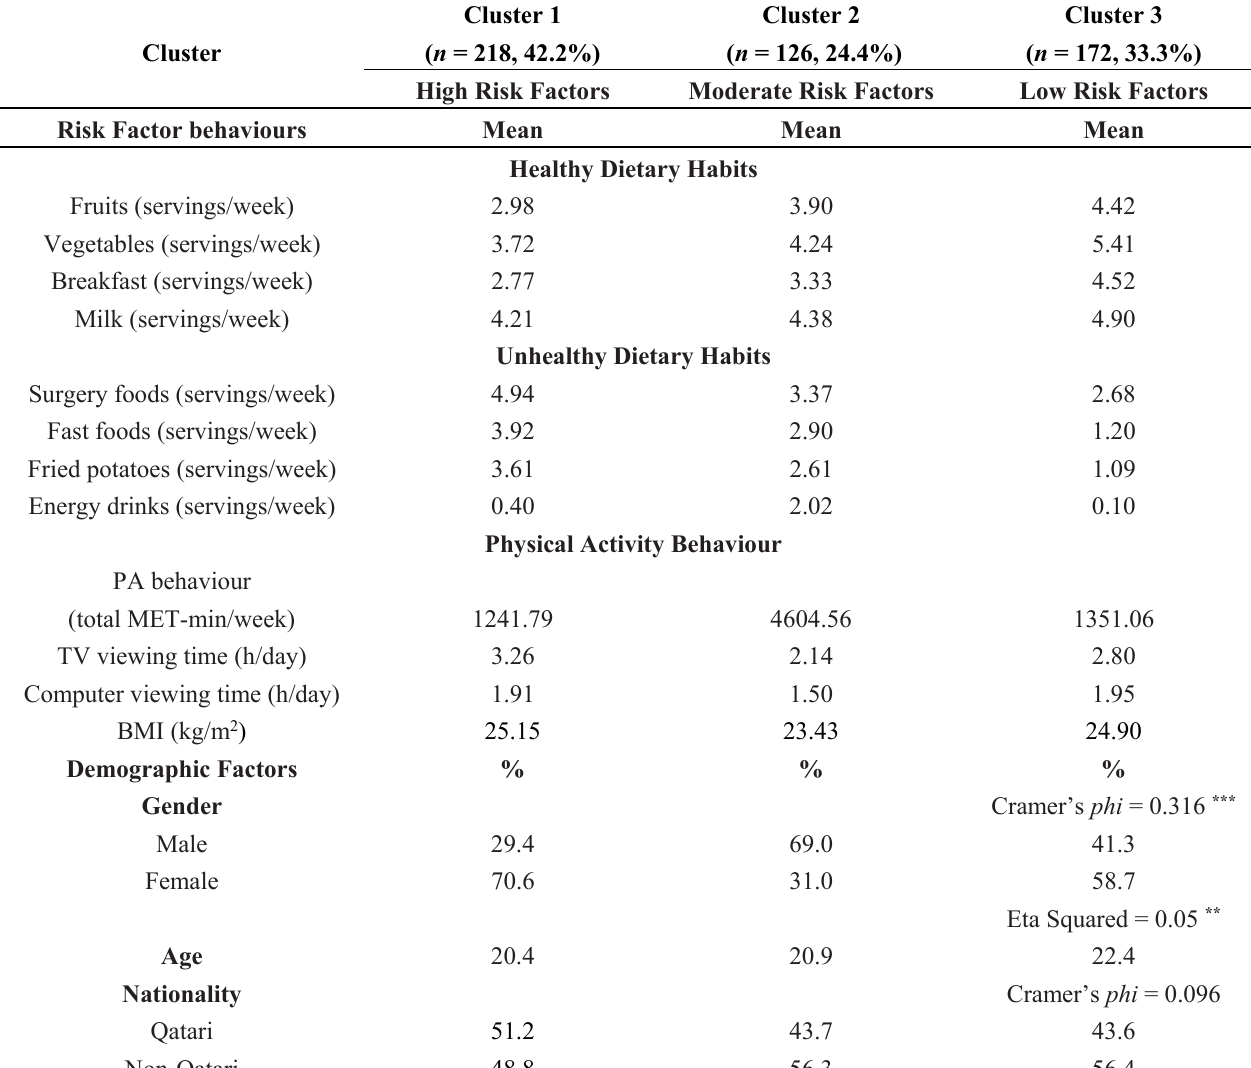
Table 4. Descriptive statistics for the three clusters of risk factor